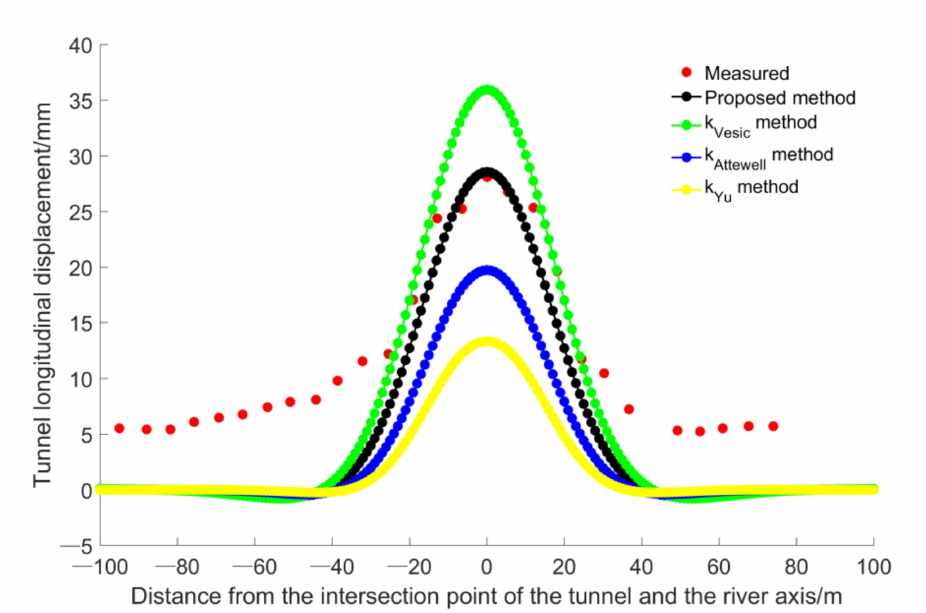
Figure 11. Comparison between the measured and computed results for the Zhongjiu section of Shanghai Metro Line